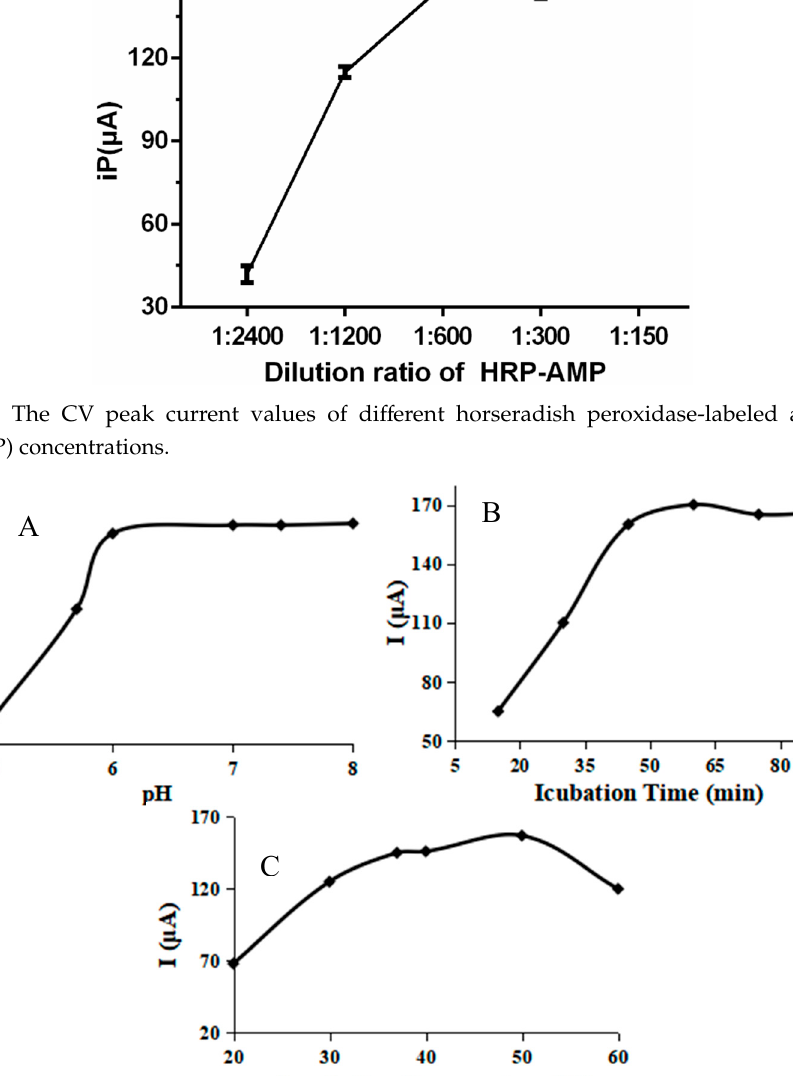
Figure 6. The CV peak current values of different pH, times and temperatures. ( A ) represents the effect of PH on the peak current. ( B ) represents the effect of time on the peak current. ( C ) represents the effect of temperature on the peak current.